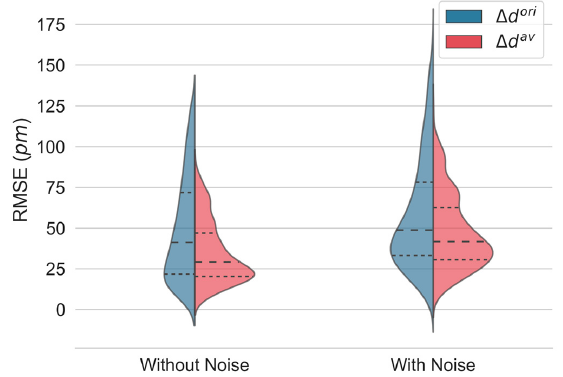
Figure 5. Kernel density estimates of the root-mean-square error (RMSE) of displacement estimation in simulated interferograms without and with noise using the original ( ∆ d ori ) and the proposed estimator ( ∆ d av ). The median (dashed) and the first and third quartiles (dotted) are shown.